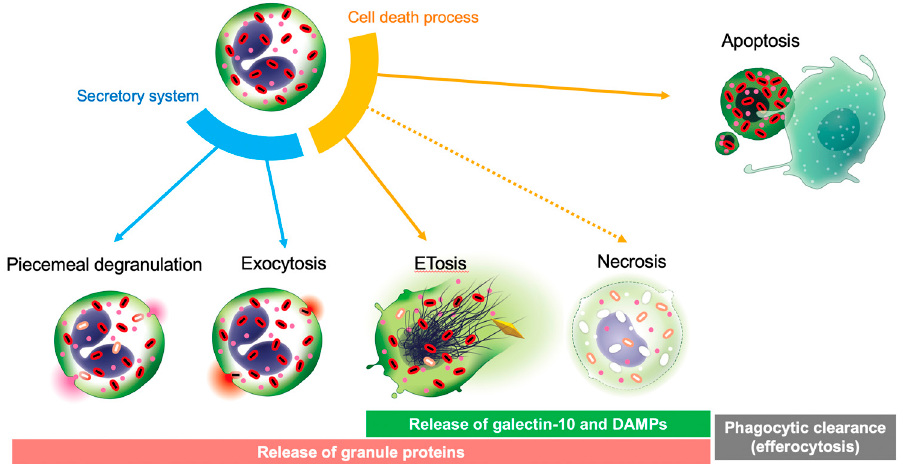
Figure 3. ETosis-mediated galectin-10 release. Live eosinophils secrete granule proteins through piecemeal degranulation and exocytosis. Eosinophils have at least two distinct active cell death pathways of apoptosis and ETosis. Unlike apoptotic cells, which are engulfed and digested by phagocytes (efferocytosis), eosinophils can undergo ETosis in tissue and release their cellular content, including cytoplasmic galectin-10, entire secretory granules, and damage-associated molecular patterns. Therefore, ETosis is also considered a form of eosinophil secretion.